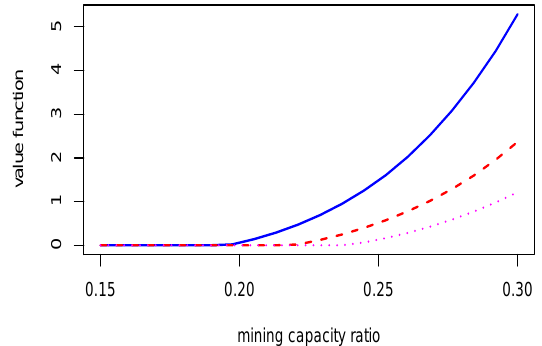
( 0,2 ) of the double-spending attack for n = 6 confirming blocks depending on Figure 3. The value ν ∗ 0 [ 0.15,0.3 ] calculated for C = 100, C = 50, and C = 30 (solid, dashed, and dotted the mining ratio q ∈ line